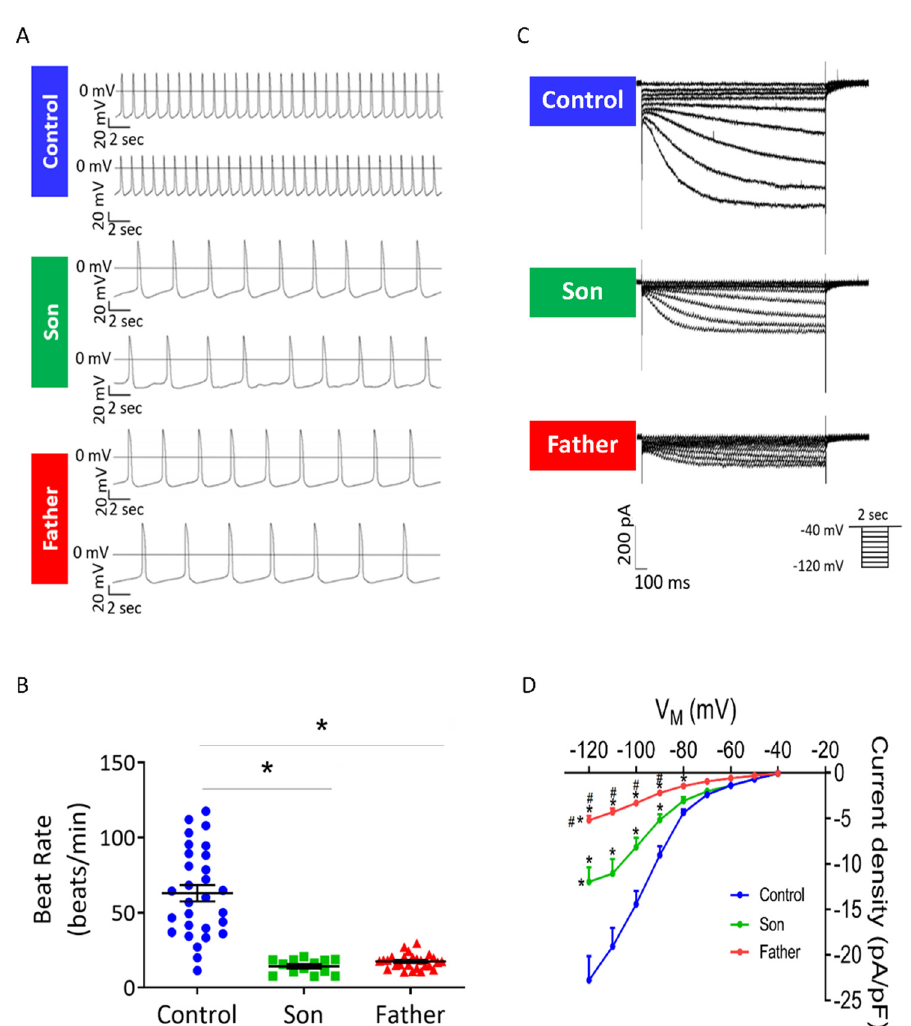
Figure 3. Spontaneous beat rate and I f in control, father and son iPSC-CMs. ( A ) Representative spontaneous action potentials recorded from control, father and son iPSC-CMs. ( B ) Mean beat rate of control, father and son iPSC-CMs. control (FSE-5 m and 24.5), n = 30; son, n = 14; father, n = 27. One-way ANOVA was performed followed by Holm–Sidak post hoc analysis. * p < 0.05. ( C ) Representative recordings of I f in control, father and son iPSC-CMs. ( D ) I f current–voltage (I–V) relations in control and LMNA -mutated iPSC-CMs. Control (FSE-5 m), n = 8; son, n = 10; father, n = 18. Two-way ANOVA was performed followed by Holm–Sidak post hoc analysis. * p < 0.05 vs. control; # p < 0.05 vs. son.